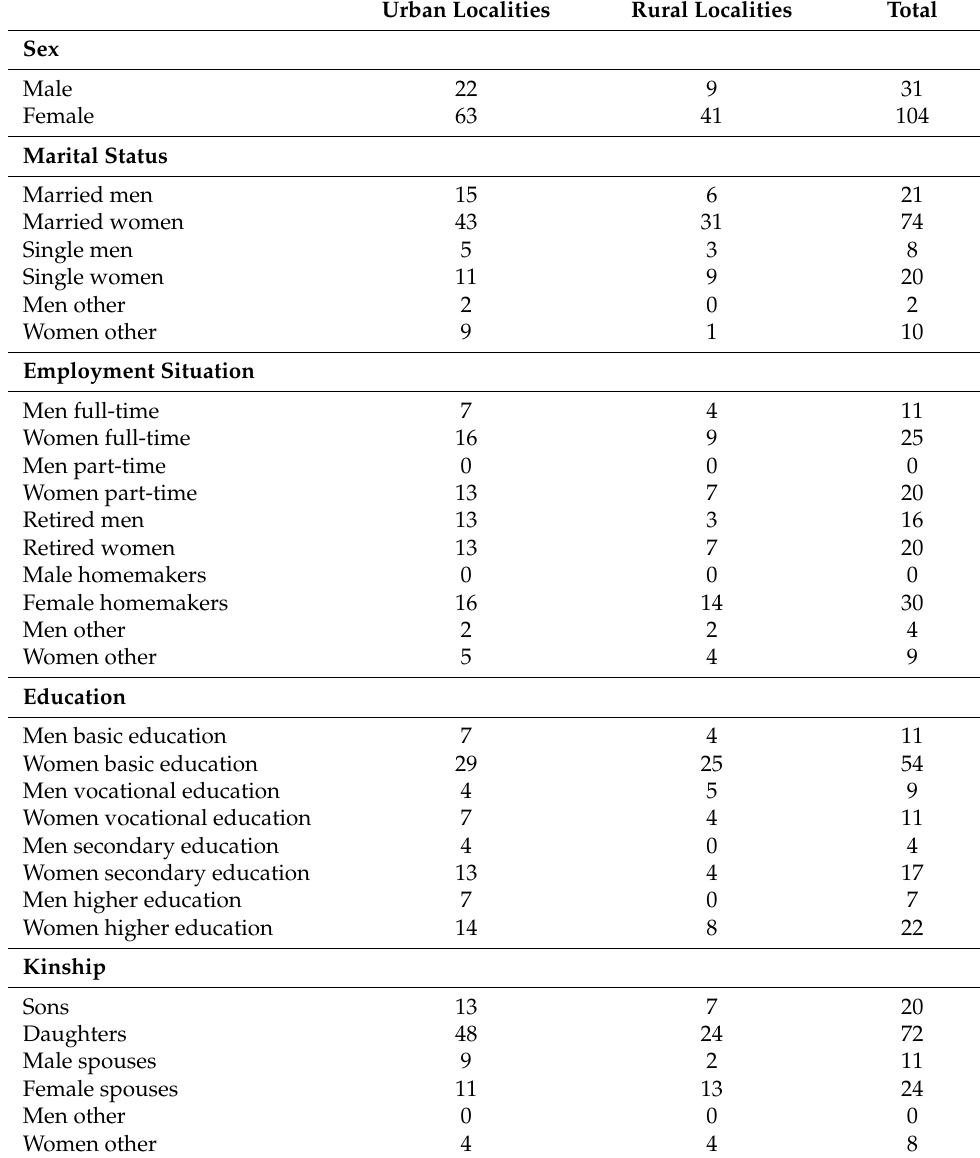
Table 2. Sociodemographic variables of family caregivers; number by location. Source: own elaboration. Urban Localities Rural Localities